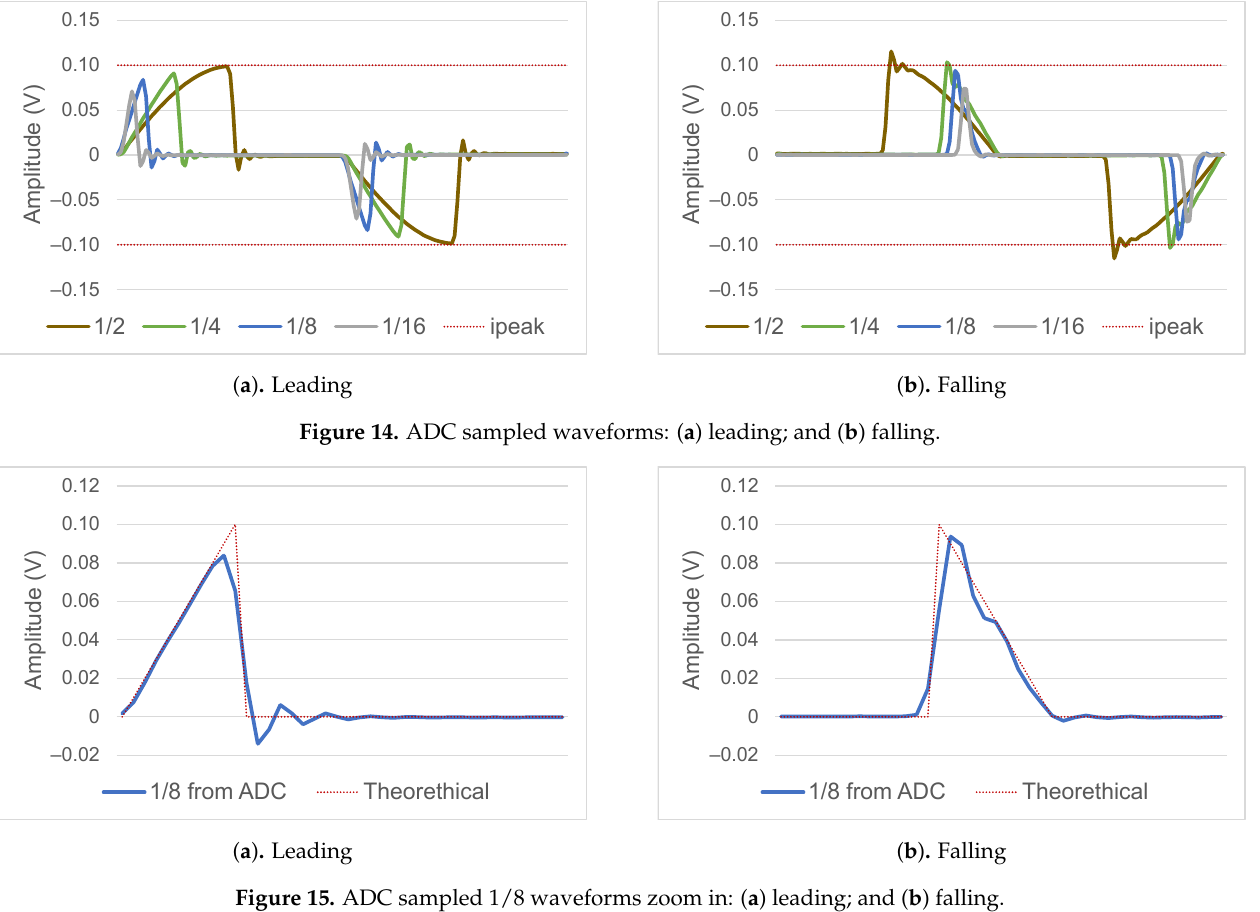
Figure 15. ADC sampled 1/8 waveforms zoom in: ( a ) leading; and ( b )